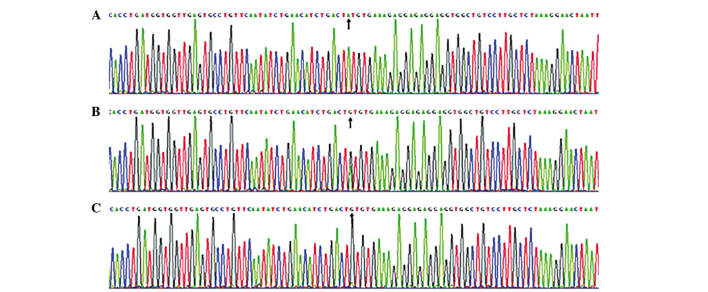
Part of the nucleotide sequence of the PABPC4 rs4660293 single nucleotide polymorphism. (A) AA genotype; (B) AG genotype; (C) GG genotype.